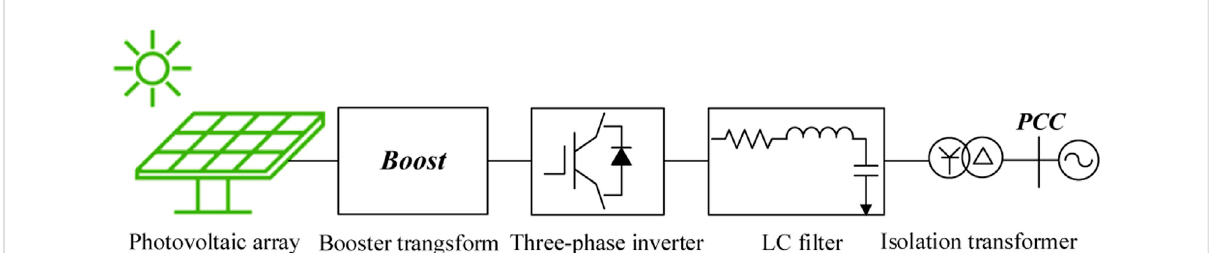
FIGURE 2 Grid connected model of PV power system.